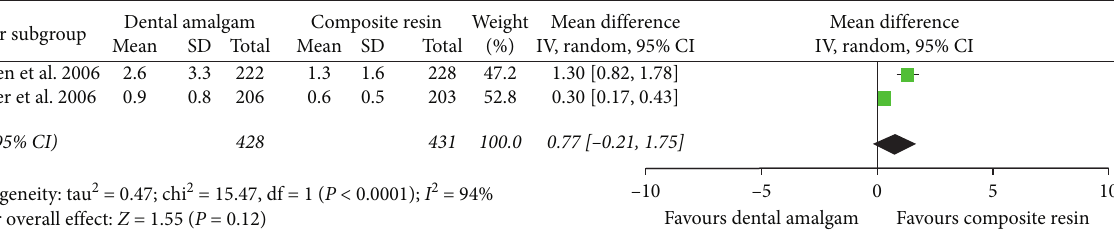
Figure 4: Forest plot of comparison for urinary mercury concentration after 5 years of exposure to dental amalgam or composite resin in children.